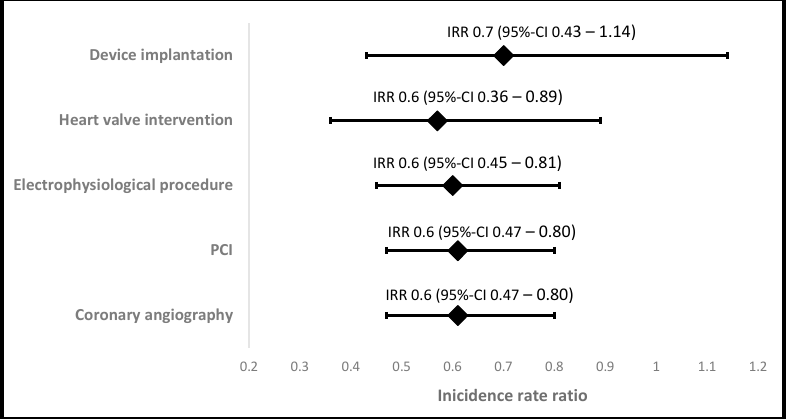
Figure 2. Incidence rate ratios of cardiac procedures during the lockdown period compared to the reference period in 2019. The x -axis displays the IRR of each intervention type during the lockdown period (20 March–19 April) in 2020 compared to the corresponding period in 2019. IRR: incidence rate ratio; CI: confidence interval; PCI: percutaneous coronary intervention. In the post-lockdown period, the numbers of non-emergency admissions did not differ significantly if compared to the respective seasonal control group in 2019 (IRR 0.91; 95%-CI 0.81–1.02; p = 0.107). Within the control year 2019, non-emergency admissions were similarly distributed across the three periods (pre-lockdown period: 13.2 ± 4.3 non-emergency admissions, lockdown period 13.4 ± 4.1 non-emergency admissions, and post-lockdown 12.9 ± 5.5 non-emergency admissions; p = 0.351) (Figure